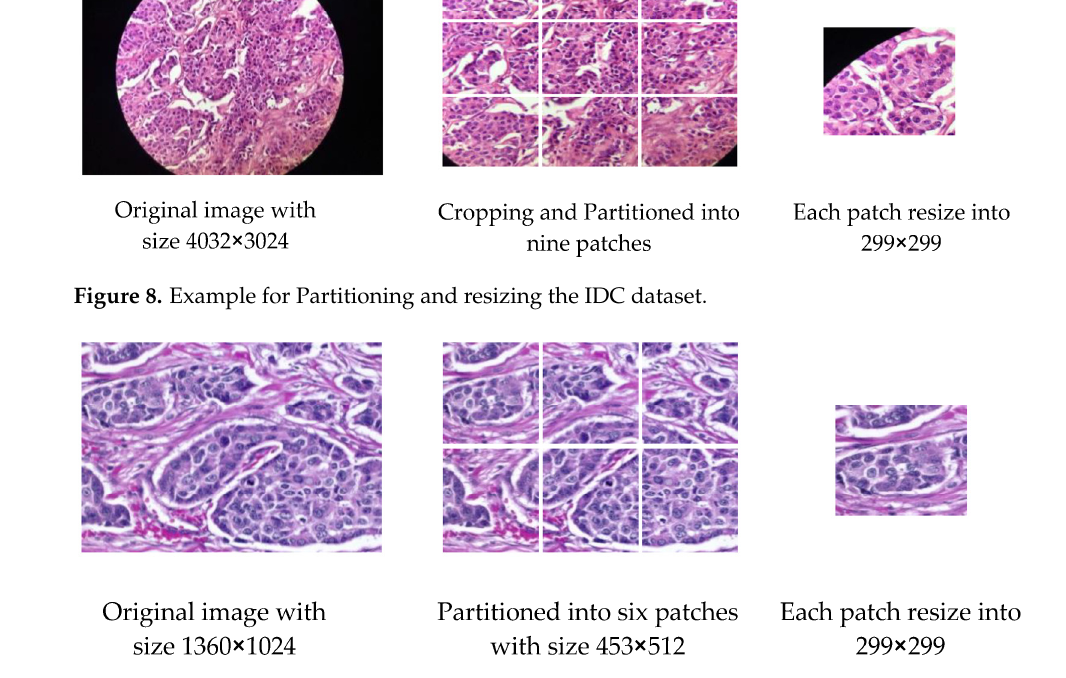
Figure 9. Example for Partitioning and resizing the BreCaHAD dataset.